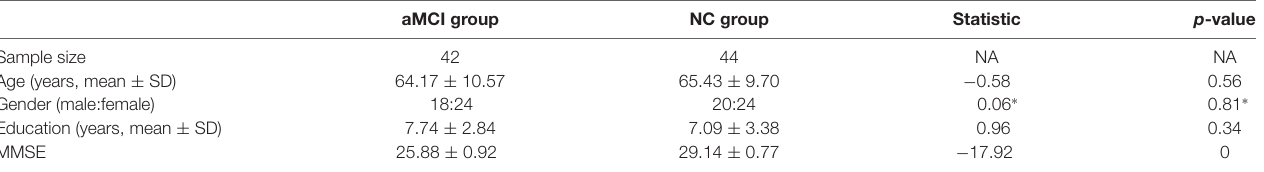
TABLE 1 | Demographics performances of the aMCI and normal controls.